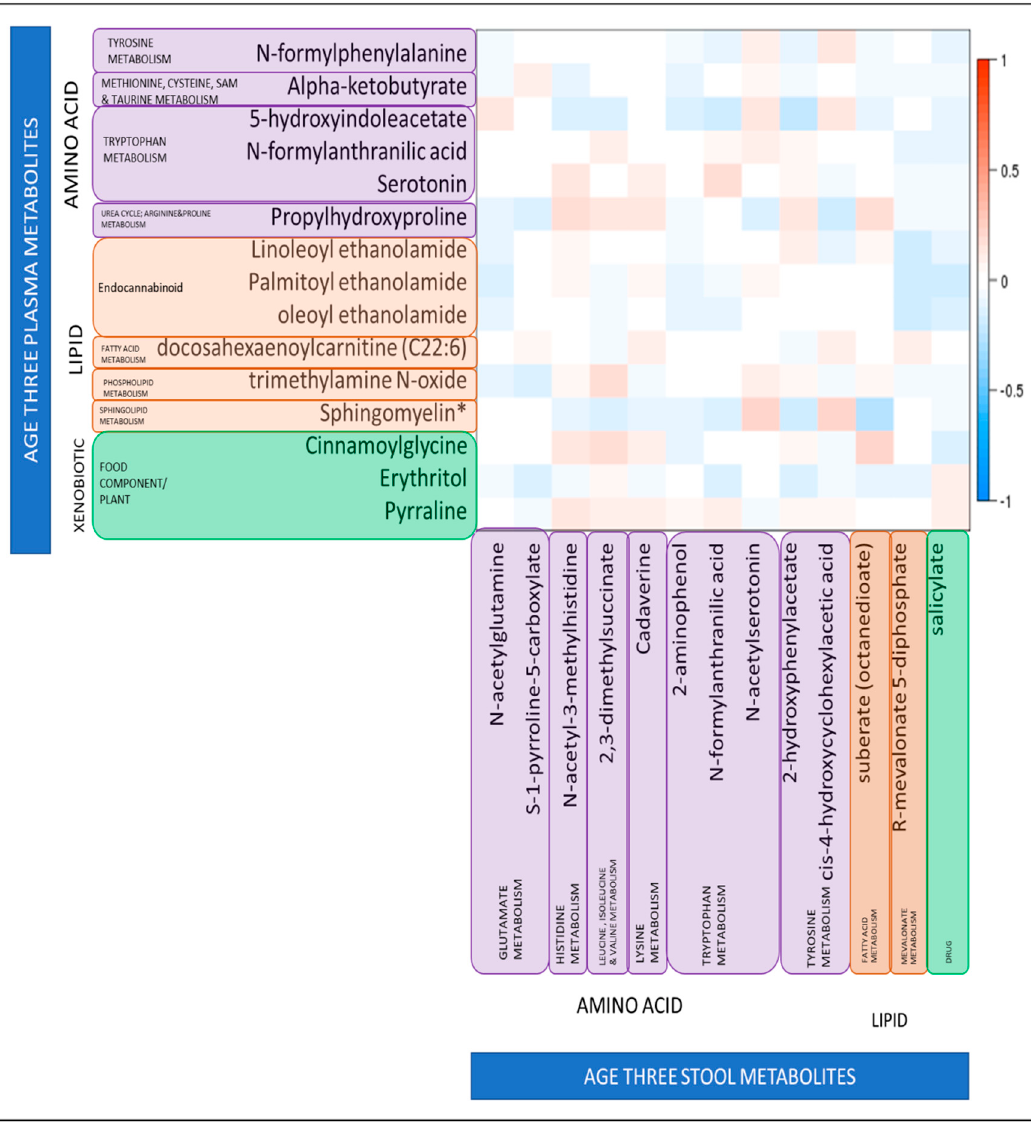
Figure 2. Relationship between levels of 15 plasma metabolites identified as significantly associated with binary ASQ score at age three, and 13 stool metabolites identified as significantly associated with binary ASQ score at age three. Relationships are quantified by Spearman’s Correlation Coefficients; color indicates direction of correlation (red is a positive correlation, blue is a negative correlation), darker shades indicate the significance of the association. White indicates no significant correlation. * Sphingomyelin (d18:1/25:0, d19:0/24:1, d20:1/23:0, d19:1/24:0)